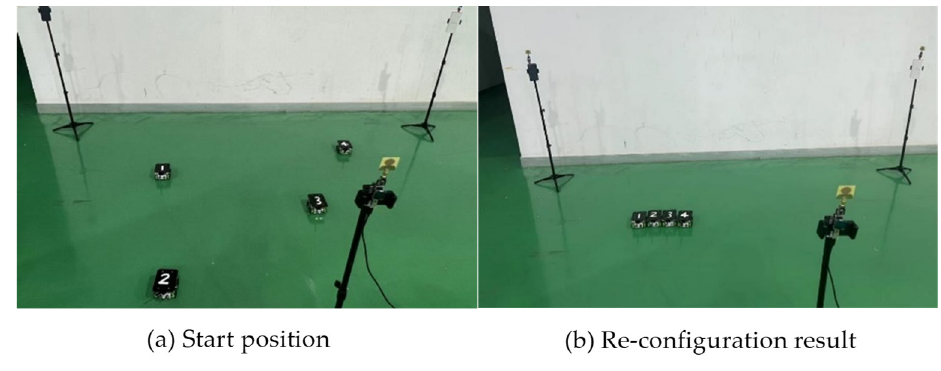
Figure 22. “—” shape reconfiguration procedure.